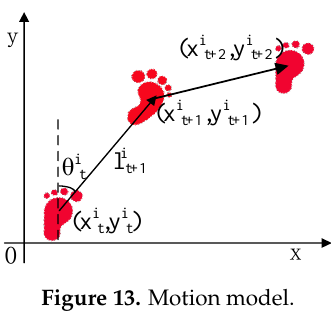
Figure 13. Motion model.